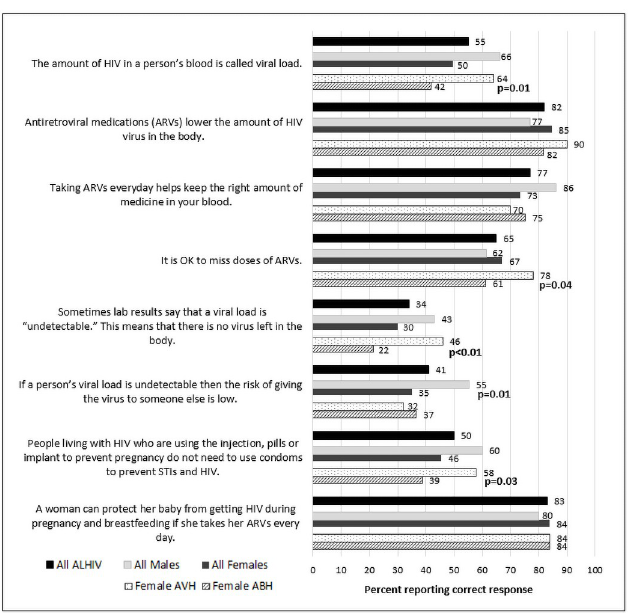
Fig 1. Proportion of ALHIV 15–19 years answering HIV knowledge questions correctly by sex and mode of transmission (vertically vs. behaviorally acquired HIV), Nampula, Mozambique, 2019 (N = 208).